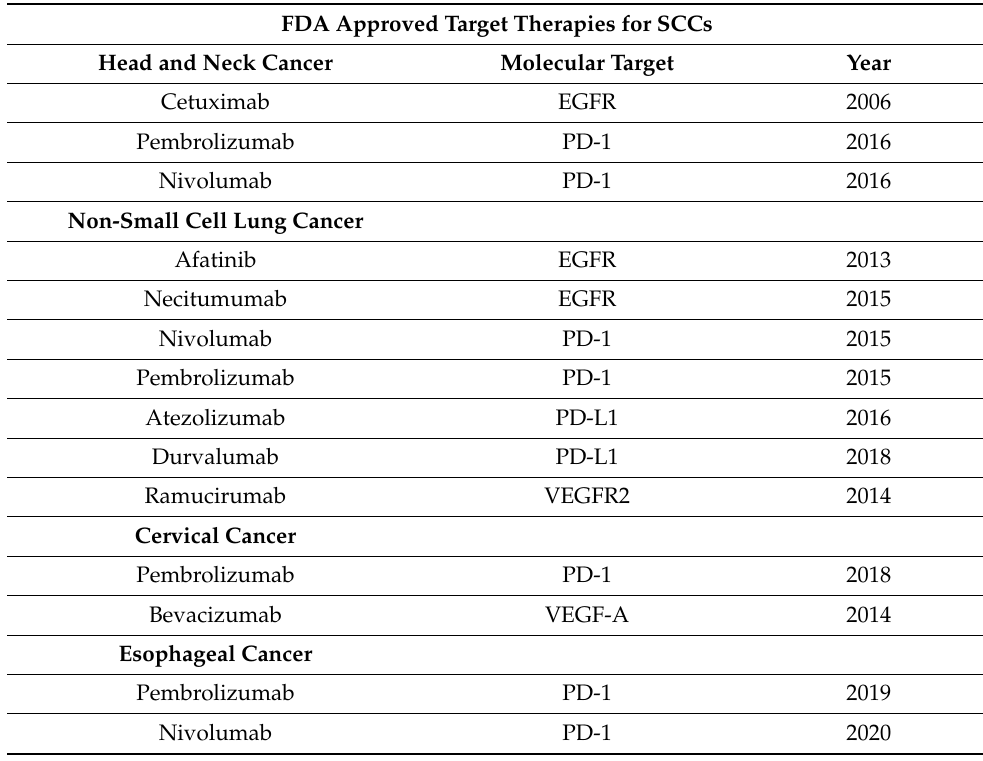
Table 1. FDA-approved molecules outside of chemotherapy for treatment of SCCs. FDA Approved Target Therapies for